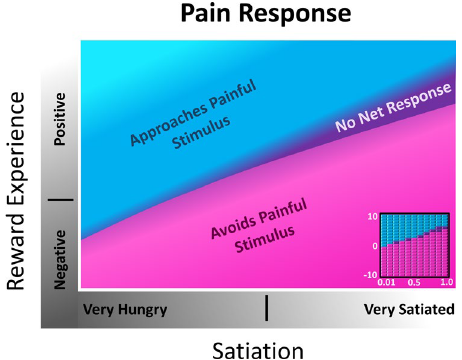
Figure 5. Effects of satiation and reward experience on response to pain. In general, positive reward reduces the ASIMOV forager’s aversion to pain, while negative reward enhances it. Net responses to pain application are classified as approach turns to the stimulus, no net turn, or avoidance turns. Relations are smoothed from coarser quantitative data shown in the inset at the bottom right corner, where satiation is varied from 0.01 to 1.0, and reward experience is varied from − 10 to 10 in the simulations. In a neutral reward experience, the forager makes an approach turn towards pain at very low satiation, and avoidance turns at higher satiation levels. A positive reward experience reduces the effect of pain, causing approach turns towards pain at higher satiation levels, while negative reward experience causes aversive turns at all levels of